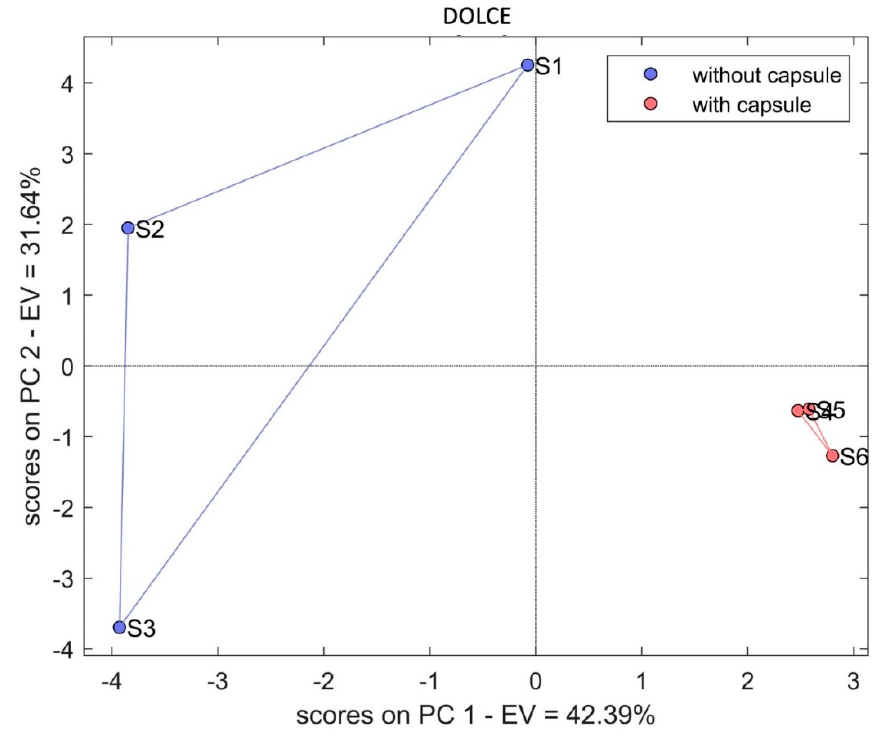
Figure 7. PCA score showing the comparison between volatile spectra compound of Dolce coffee “with capsule” and “without capsule” exhibiting an EV (explained variance) = 74.03%.